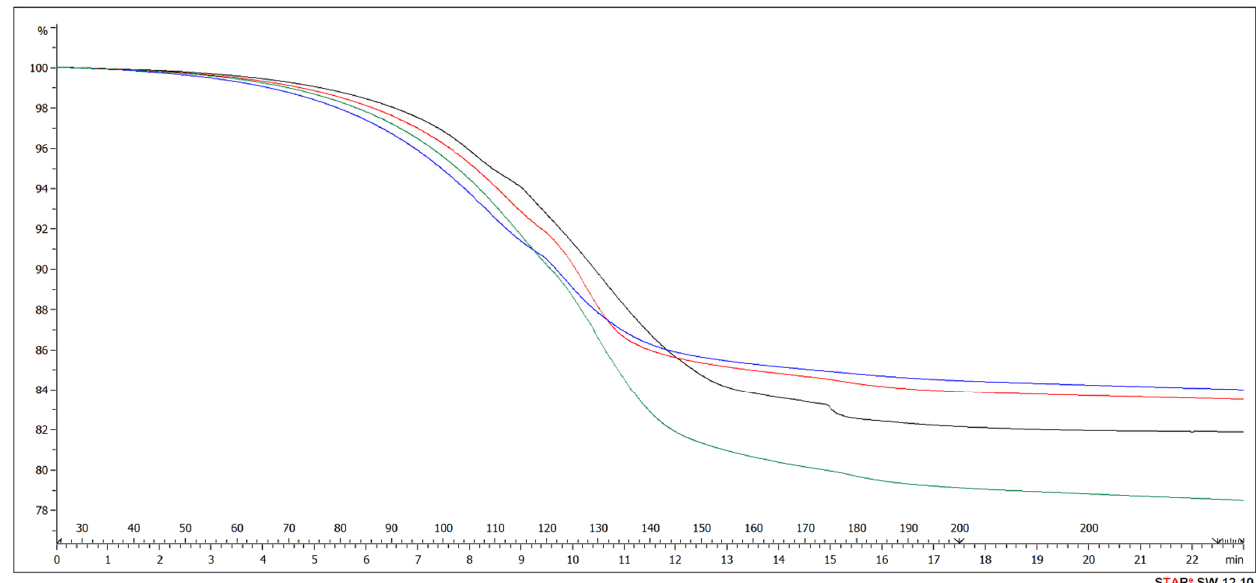
Figure 12. Left part: TGA curves to 200 °C of UF (black: UF, red: HDF Type 1, blue: HDF Type 2, green: HDF Type 3). Right part: isothermal section at the temperature of 200 °C.